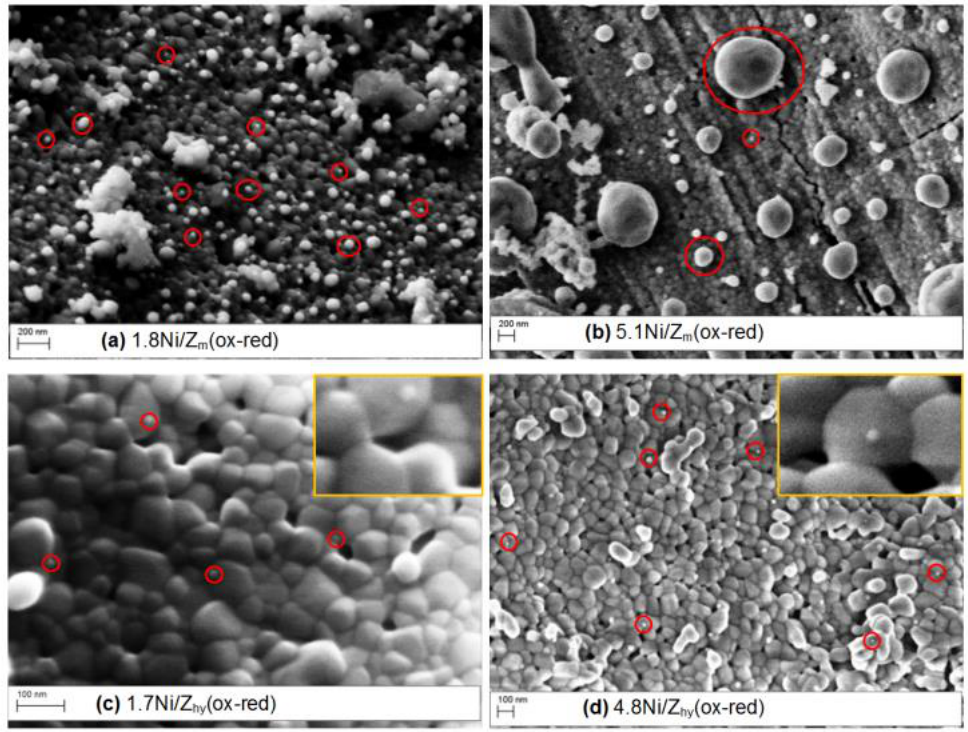
Figure 6. FESEM images of Ni/Z hy ( ox-red ) and Ni/Z m ( ox-red ) catalysts. Red circles and magnifications in sections ( c ) and ( d ) highlight some Ni particles.